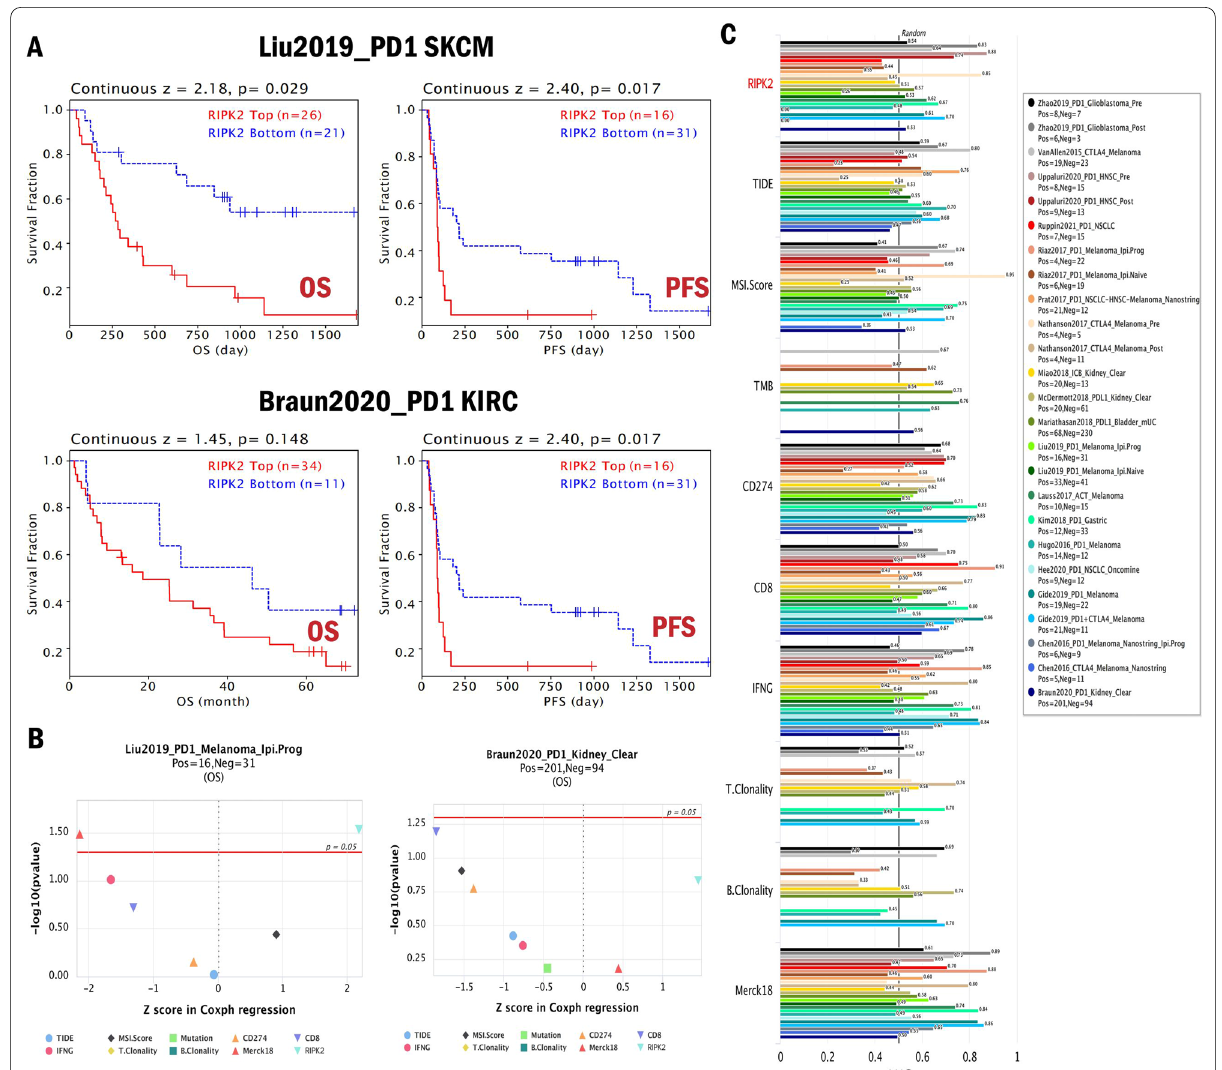
Fig. 5 Correlations between RIPK2 expression and immunotherapy response. A Kaplan–Meier survival plots (OS) comparing high and low expression of RIPK2 in SKCM and KIRC cohort studies treated with anti-PD1 drug. B The plot showed the prognostic value of RIPK2 versus standardized biomarkers in SKCM and KIRC cohort. C The bar chart showed the correlation between RIPK2 and standardized biomarkers in the immunotherapy cohorts. The area under the recipient’s working characteristic curve (AUC) was used to evaluate the predictive performance of the test biomarker to the immunotherapy response state